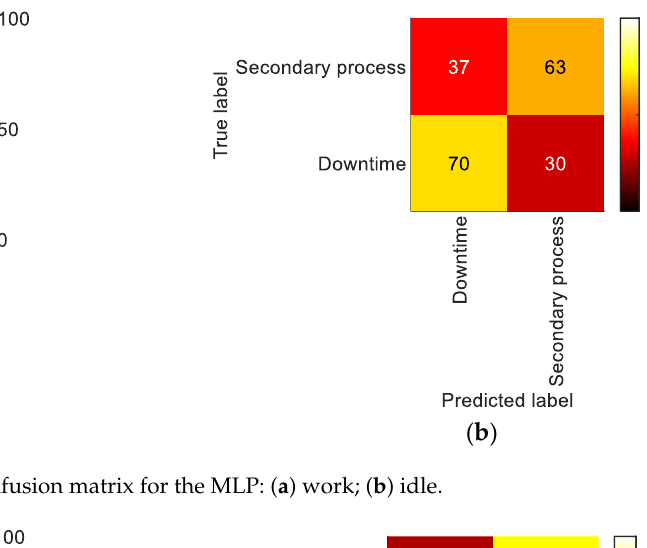
Figure A1. LoD1 confusion matrix for the MLP.